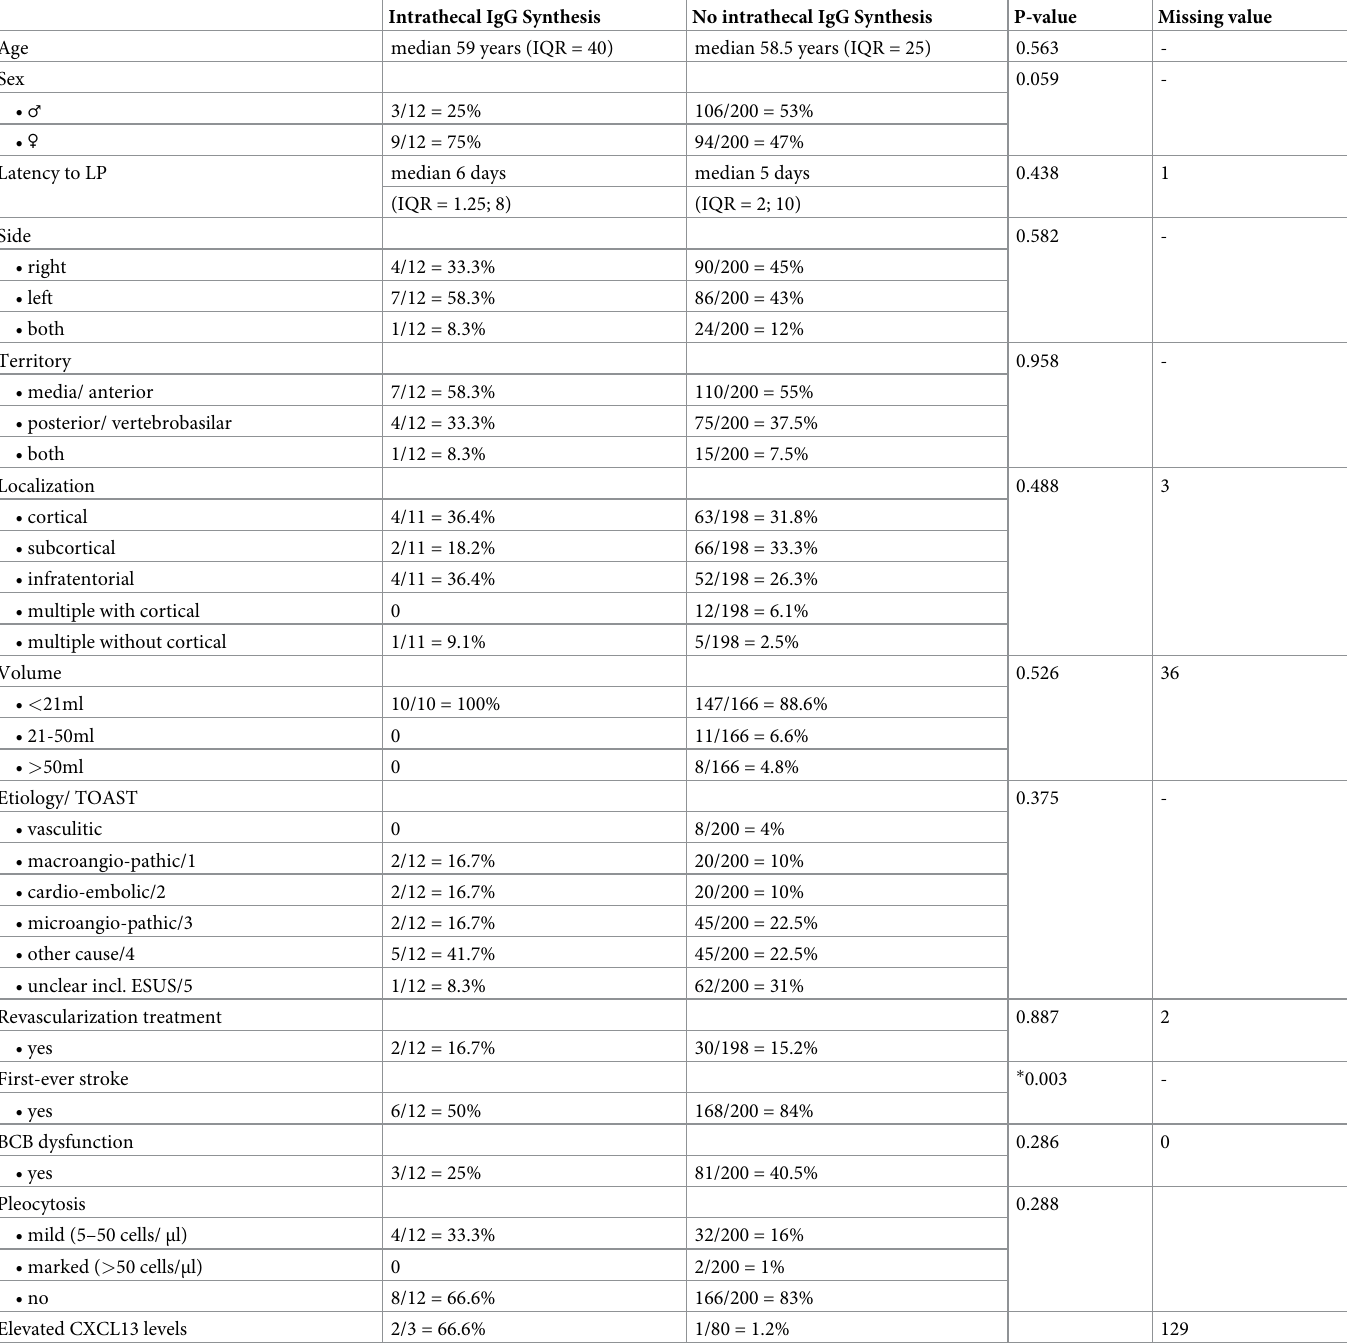
Table 1. Comparison of patients with and without elevated IgG